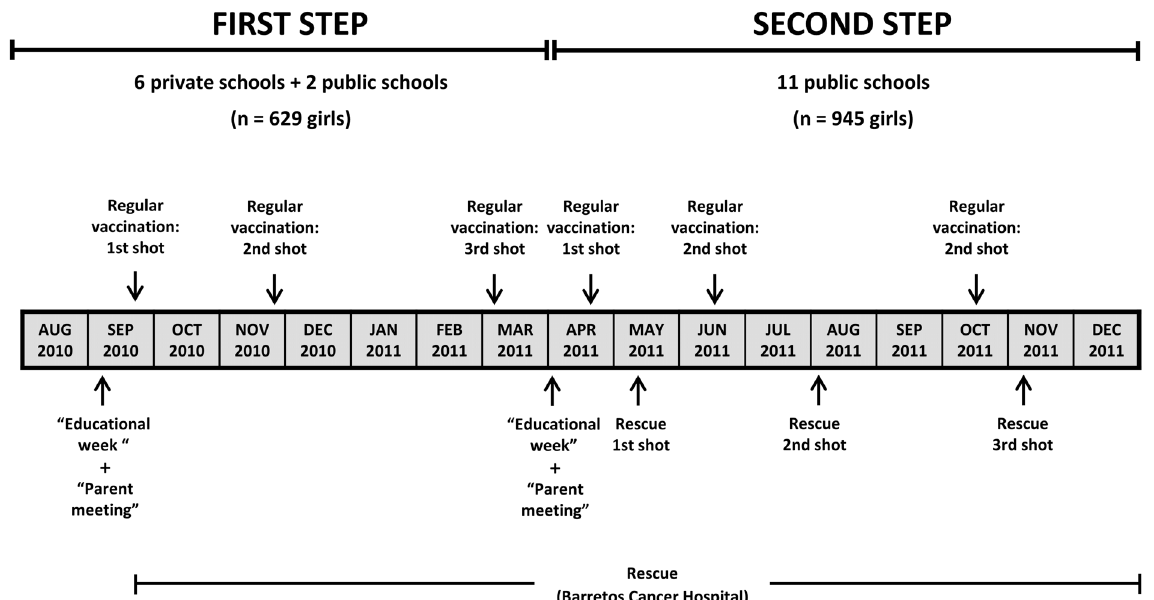
Figure 2. Design of the study (timeline).